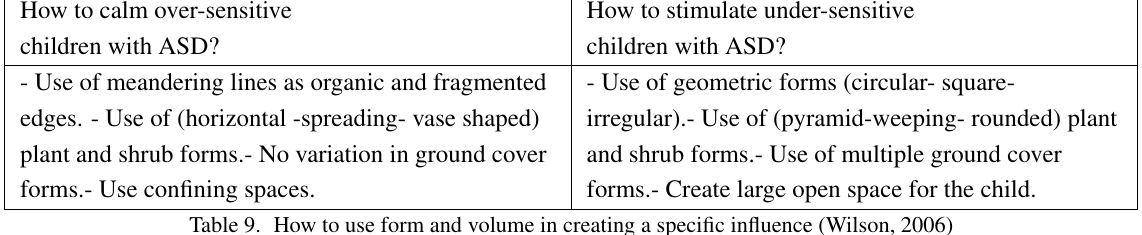
Table 9. How to use form and volume in creating a specific influence (Wilson, 2006)